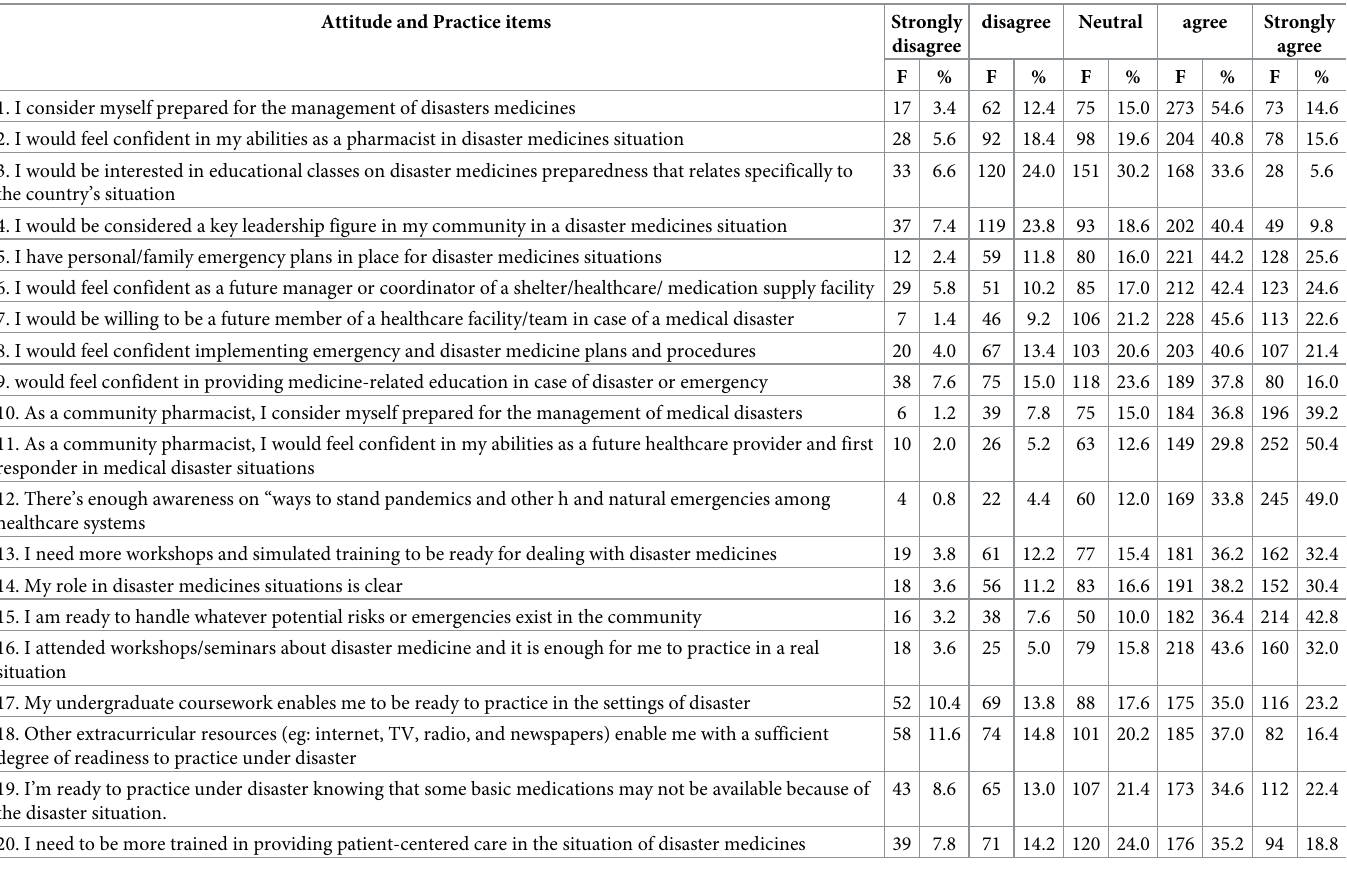
Table 4. Number and percentage of the questions on attitude and practice items. Attitude and Practice